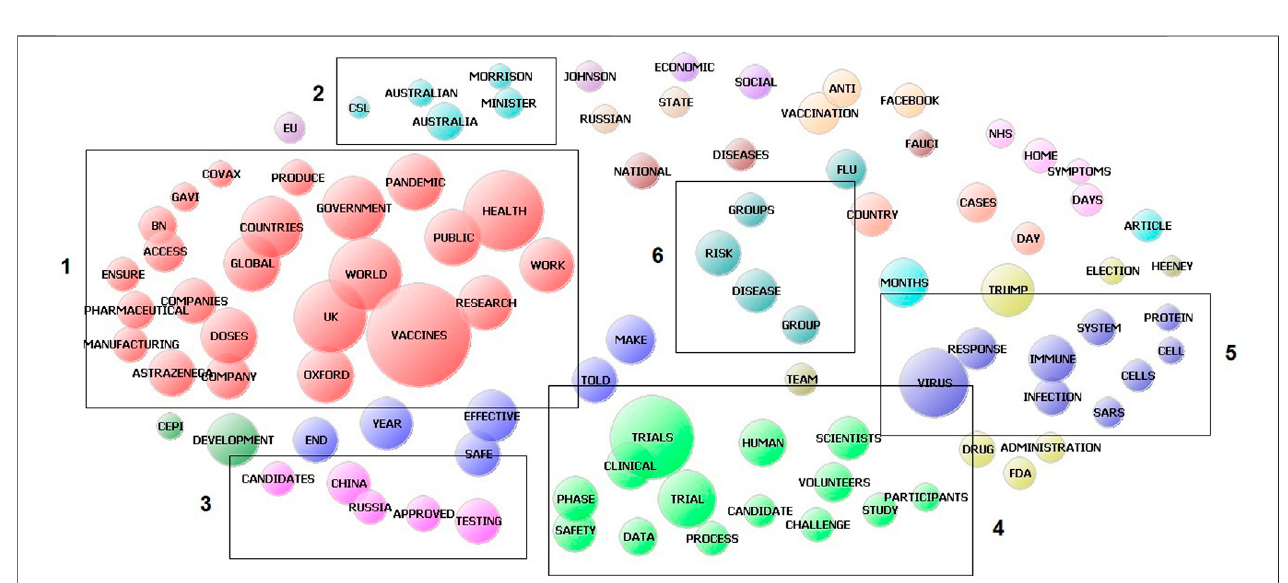
FIGURE 3 | Conceptual map with clustering of The Guardian